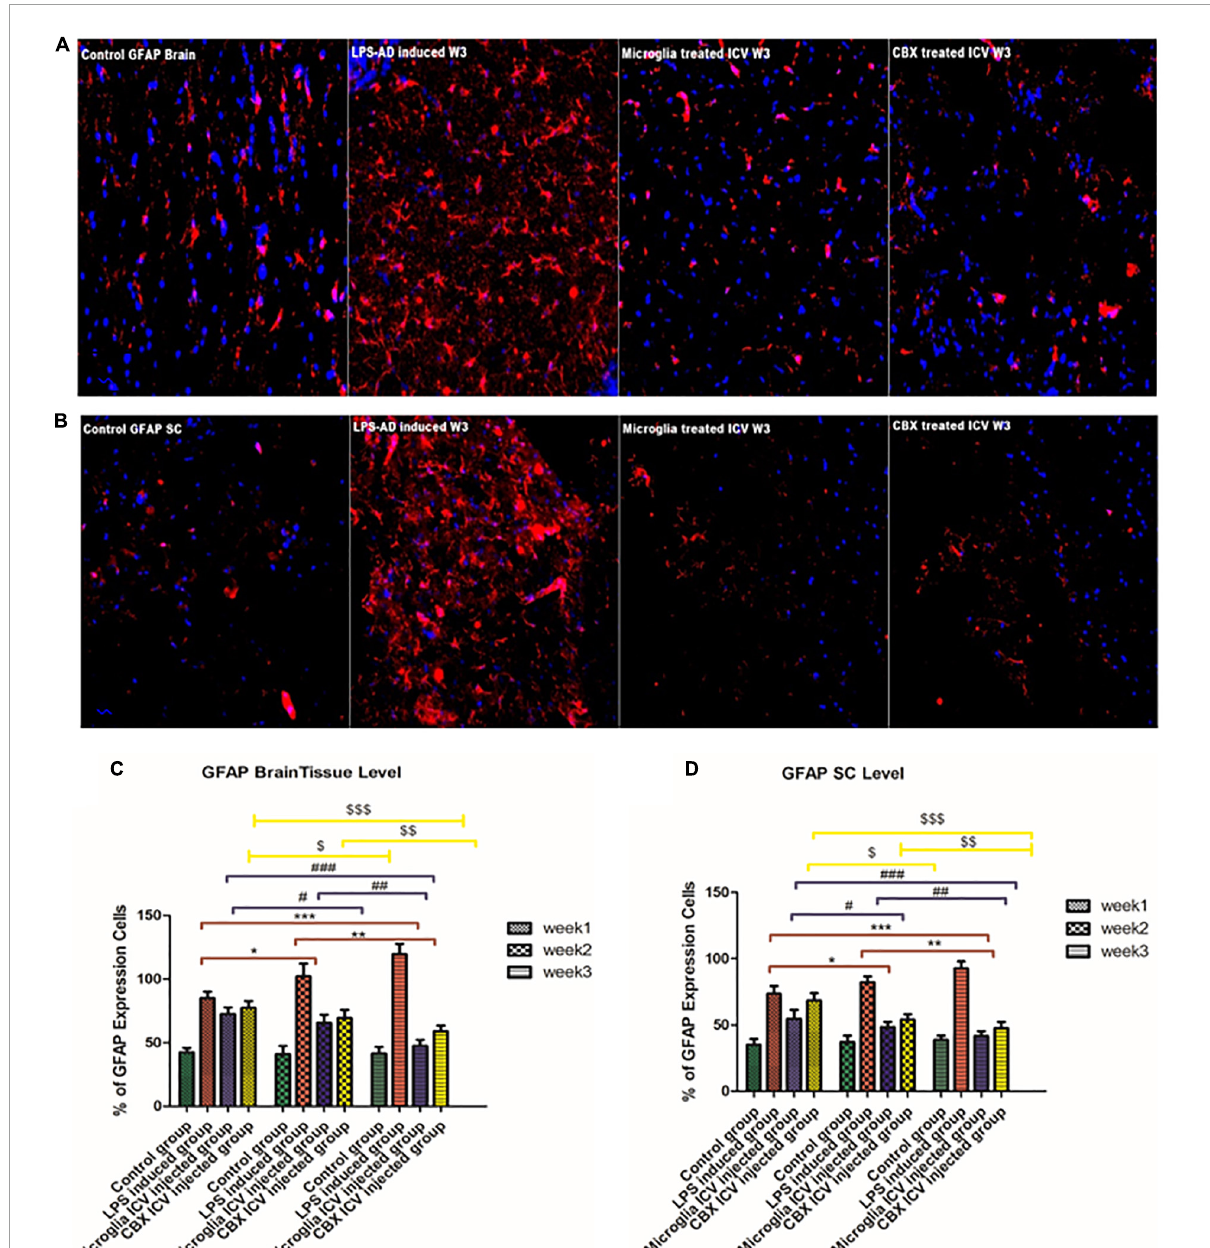
FIGURE9 Detection of glial fibrillary acidic protein (GFAP) expression level in the cerebral cortex (A) and the spinal cord (B) of the lipopolysaccharide (LPS)-induced rats and following the single intracerebroventricular (ICV) administration of primary healthy microglia (PHM) and carbenoxolone (CBX) (week 3). Increased GFAP cell expression was detected in the cerebral cortex and spinal cord sections of the LPS-induced AD neuroinflammatory model. Meanwhile, an observed decrease in the percentage of GFAP expression level was detected in the cerebral cortex and spinal cord sections following the single ICV administration of primary healthy microglia (PHM) and CBX (week 3). (C) Illustration of GFAP % expression cells level and quantitative analysis in the cerebral cortex over the 3-week time interval. (D) Illustration of GFAP % expression cells level and quantitative analysis in the spinal cord over the 3-week time interval. Represented data were expressed as mean ± SD ( n = 6 per group) (ANOVA, repeated measurement, Bonferroni post-hoc test, p < 0.05). The same asterisks represent an insignificant difference p > 0.05.